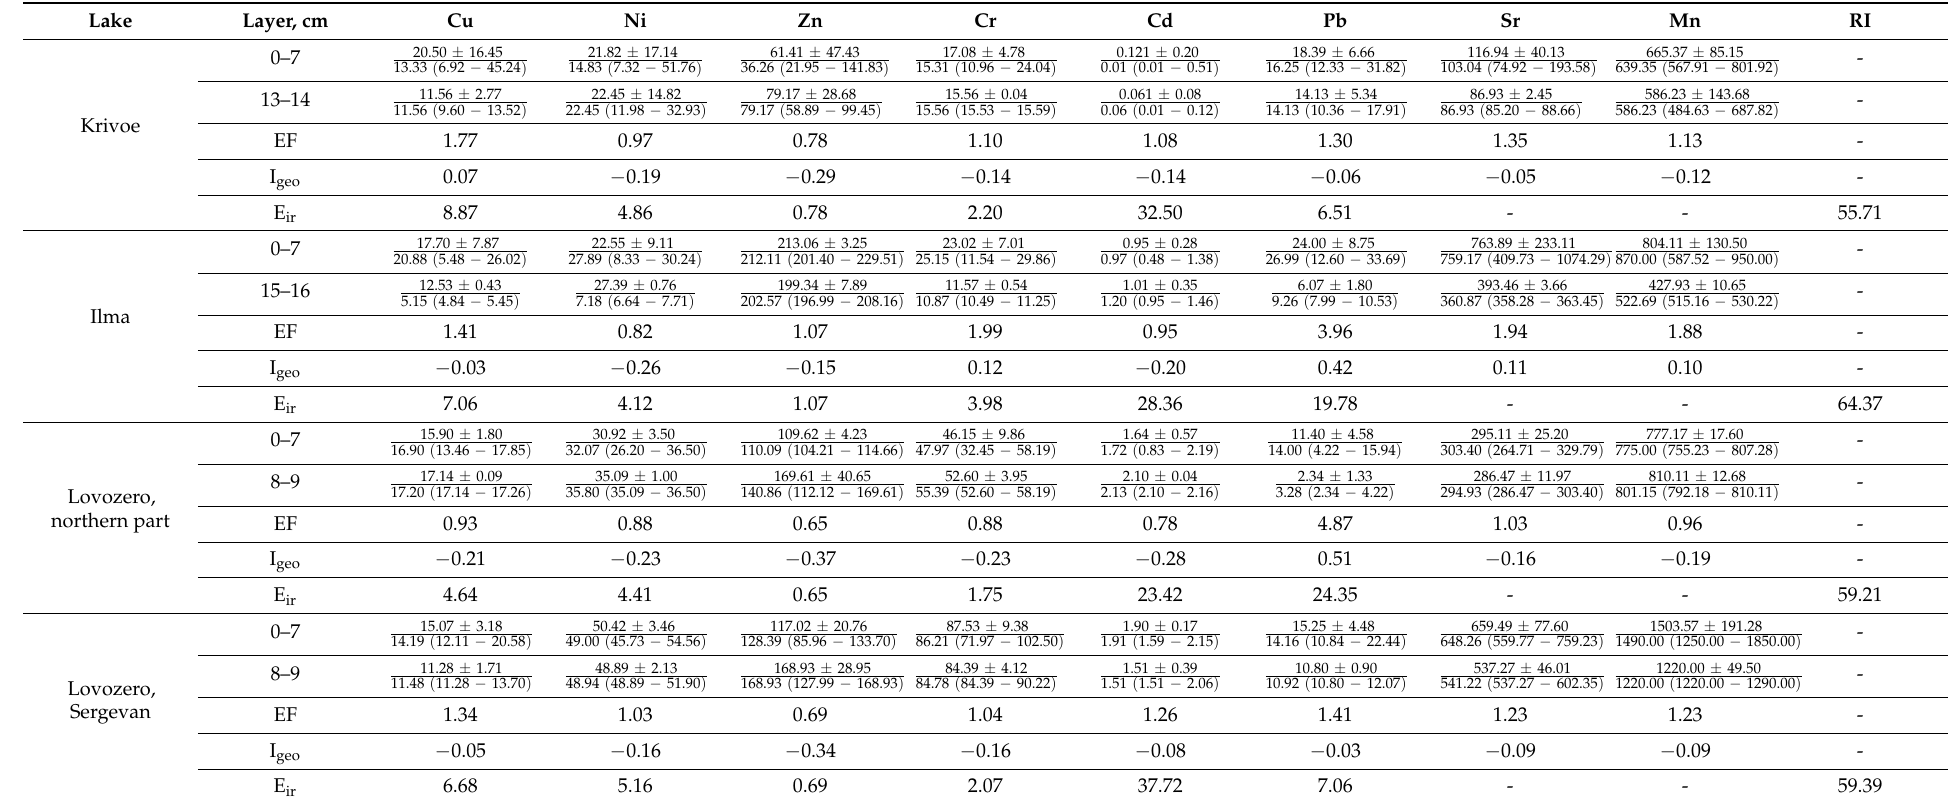
Table 4. Concentrations of TEs in the surface and background layers of BS (mg/kg), enrichment factor, geoaccumulation index, potential ecological risk index factor and potential ecological hazard